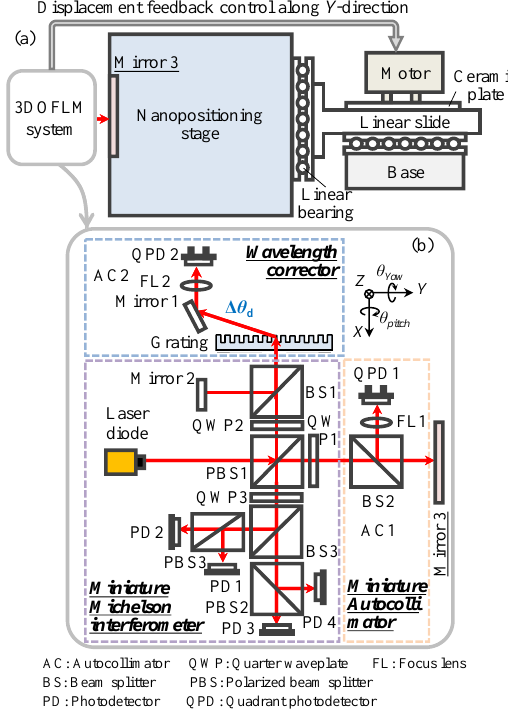
Figure 1. ( a ) Top view of configuration of the nanopositioning y -stage; ( b ) optical design of the three-degree-of-freedom laser measurement (3DOFLM) system ( xy